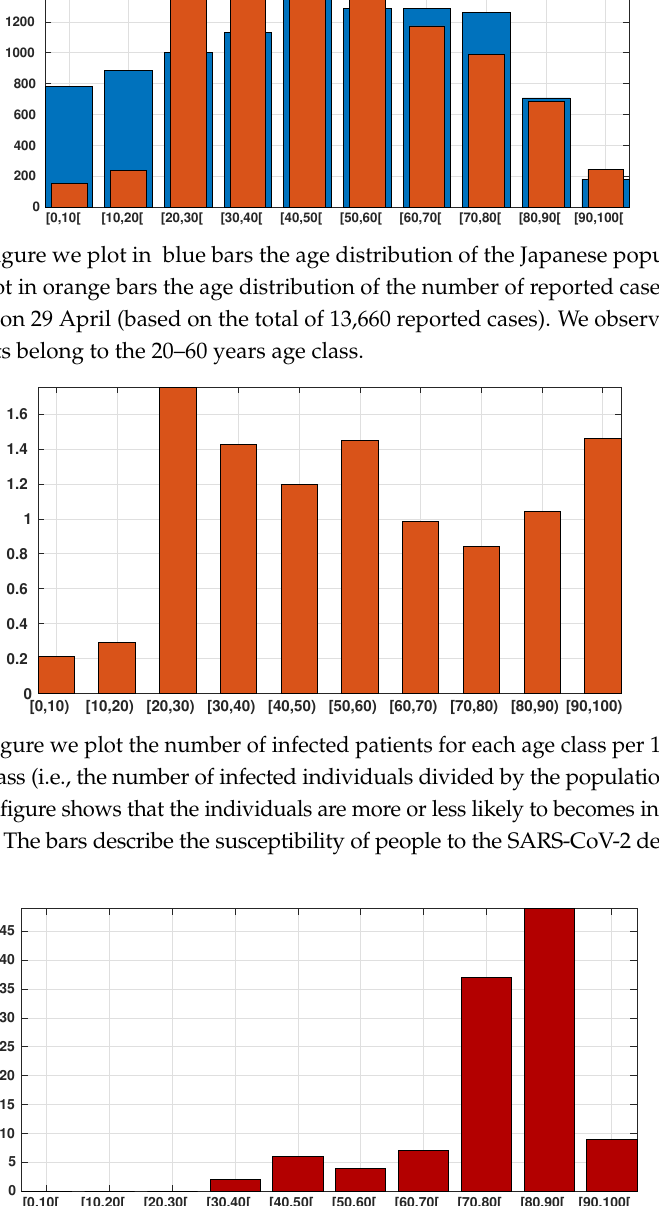
Figure 3. Cumulative number of SARS-CoV-2-induced deaths per age class (red bars). We observe that 83% of death occur in between 70 and 100 years